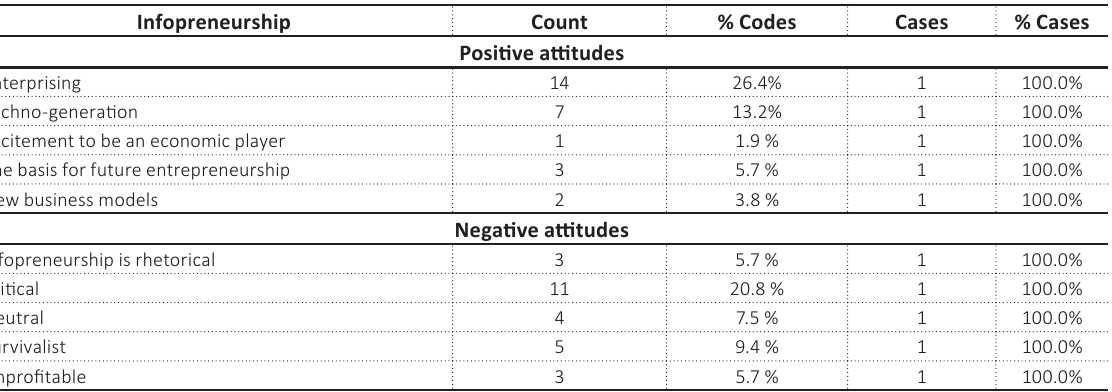
Table 3. Code frequencies